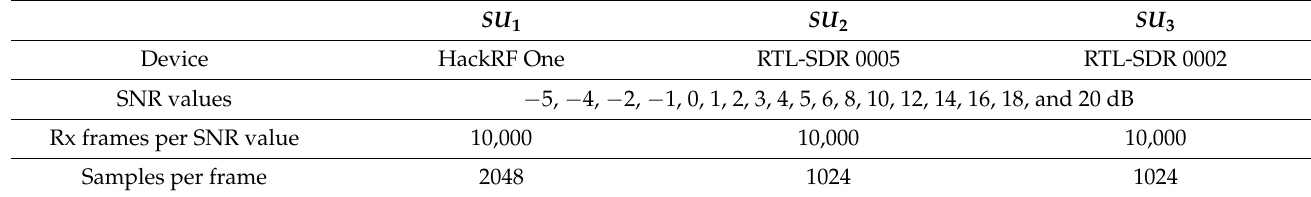
Table 3. Controlled implementation